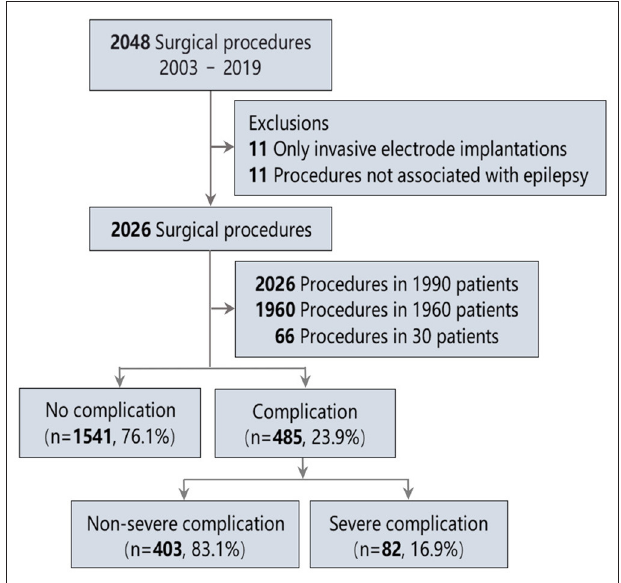
FIGURE 1 | Study diagram of selection process for assigning